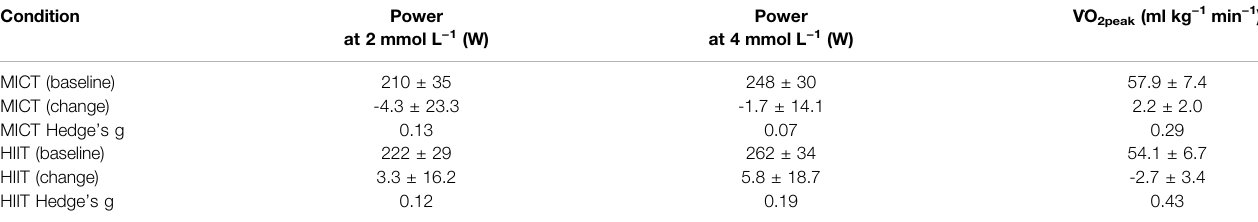
TABLE 4 | Pre to post-training change in aerobic thresholds and V _ O 2peak for the MICT and HIIT groups.